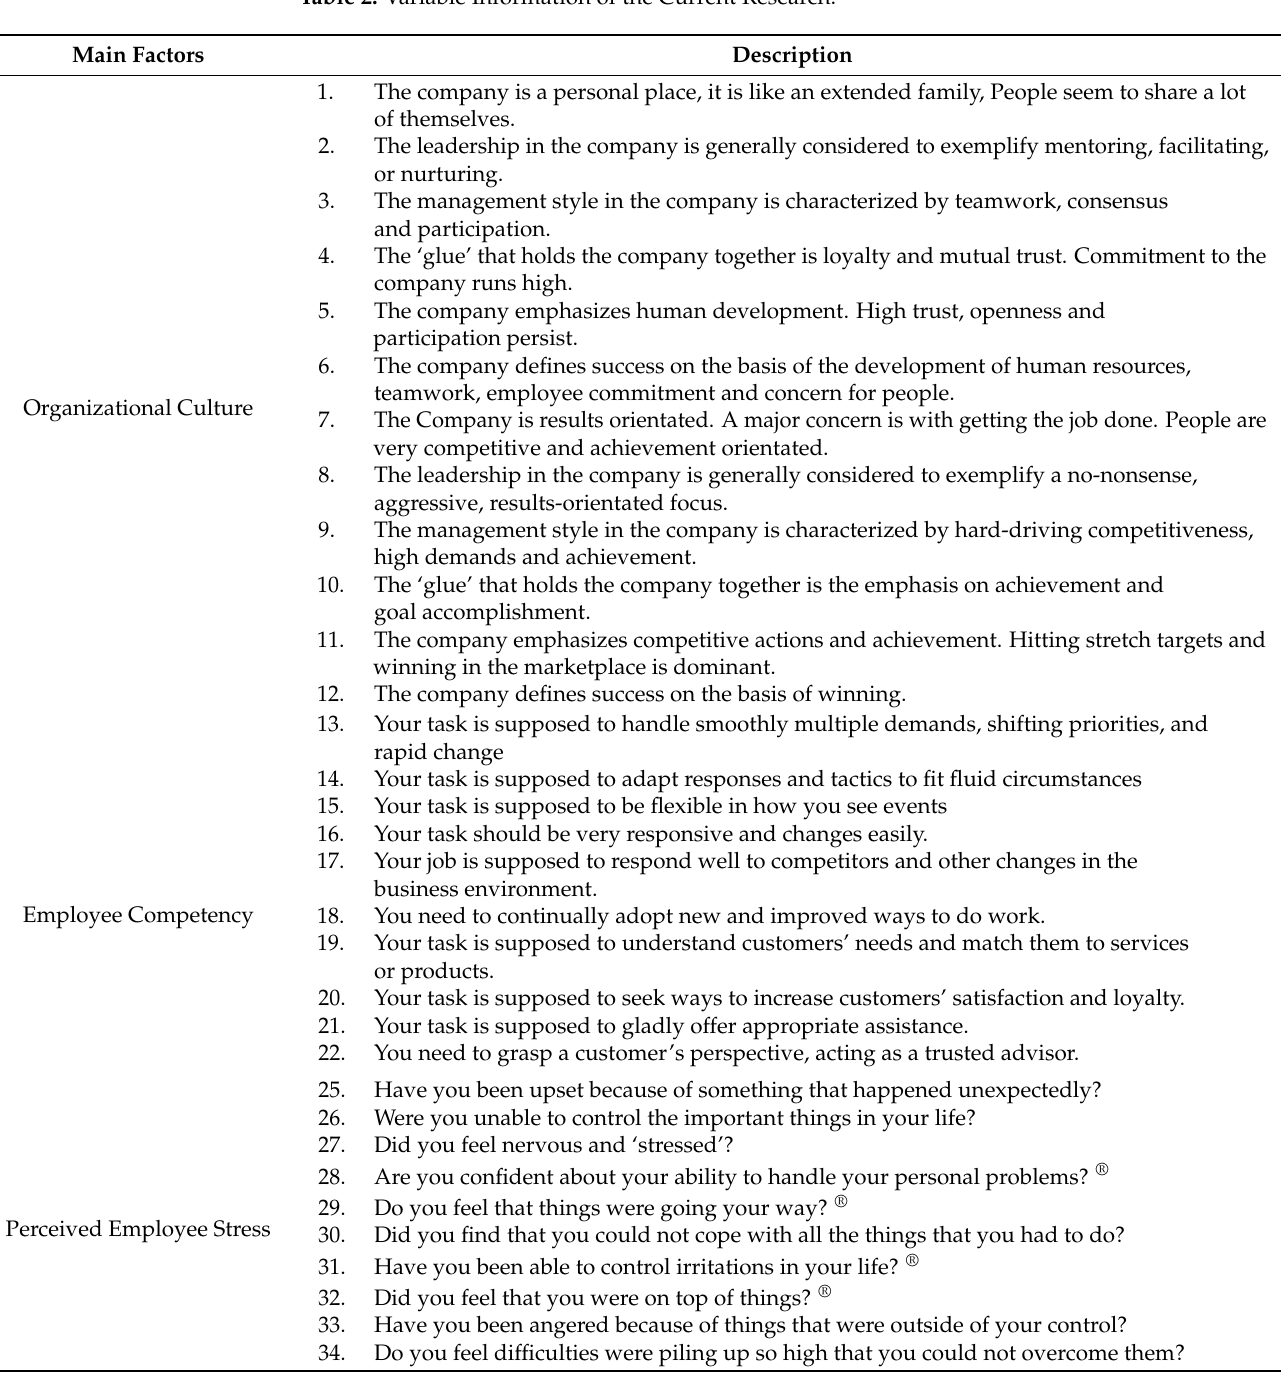
Table 2. Variable Information of the Current